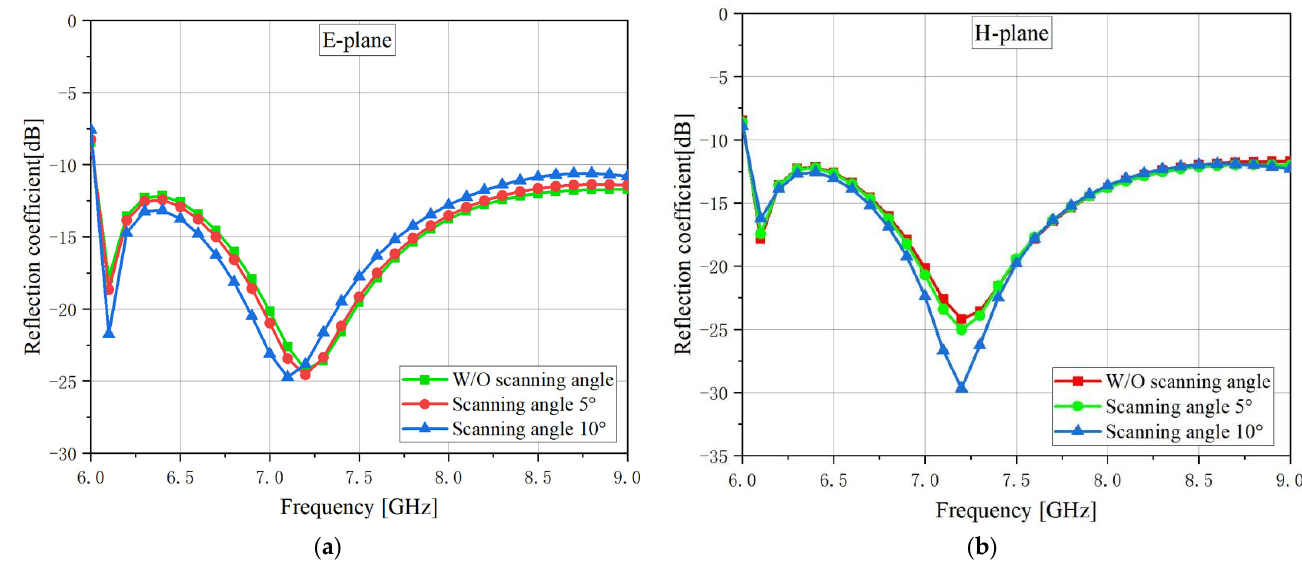
Figure 10. Active VSWR of the 8 × 8 antenna array for the high ‐ power microwave: ( a ) E ‐ plane and ( b ) H ‐ plane.